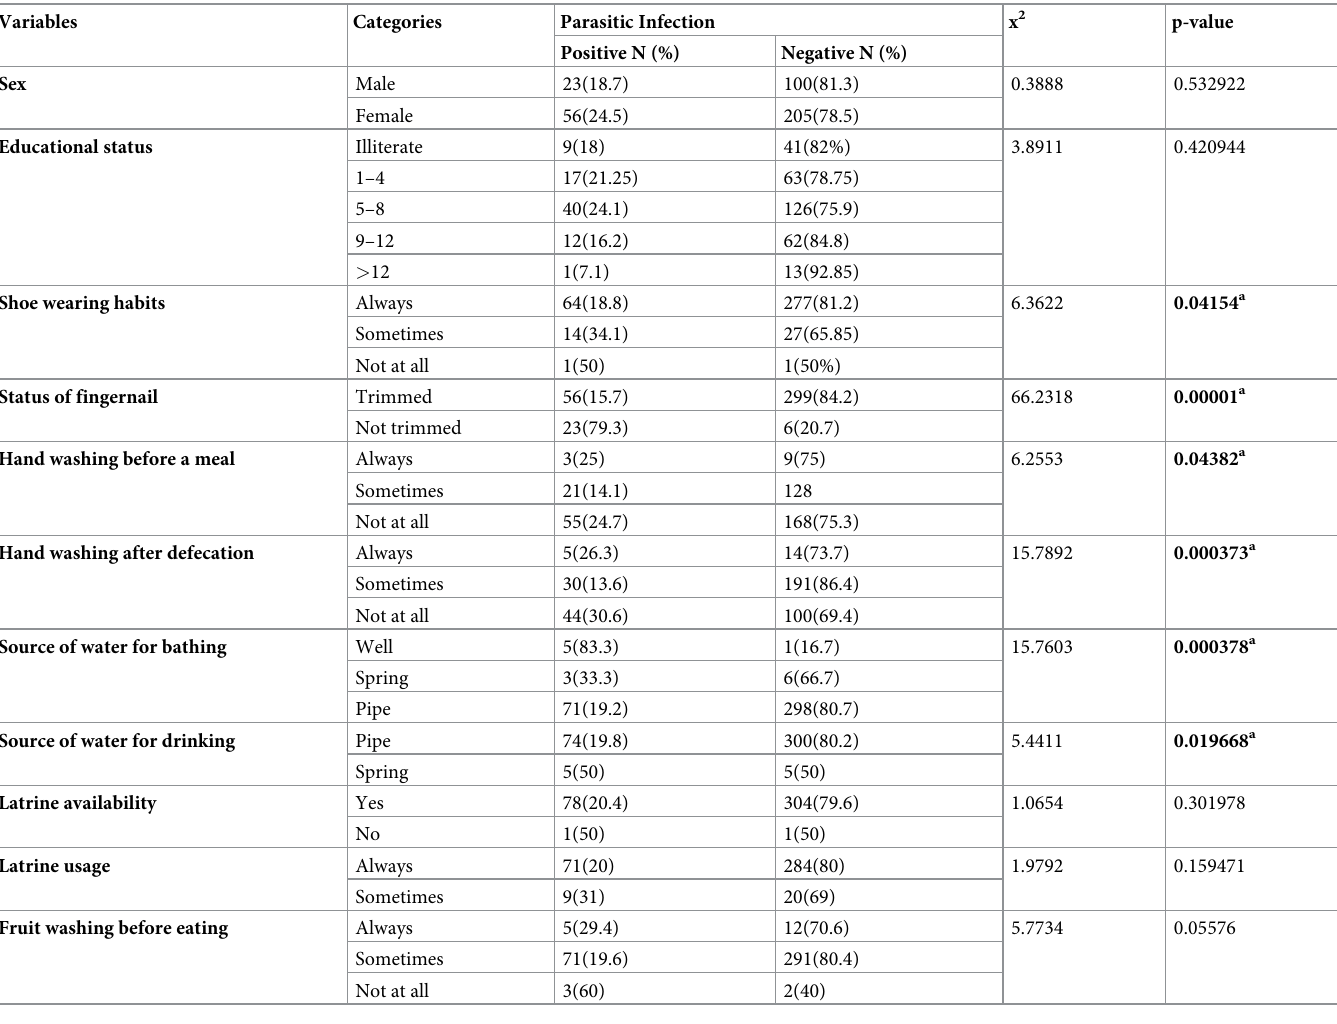
Table 4. Chi- square analysis, factors associated with the prevalence of intestinal parasitic infections among patients of Jimma health center, Southwest,